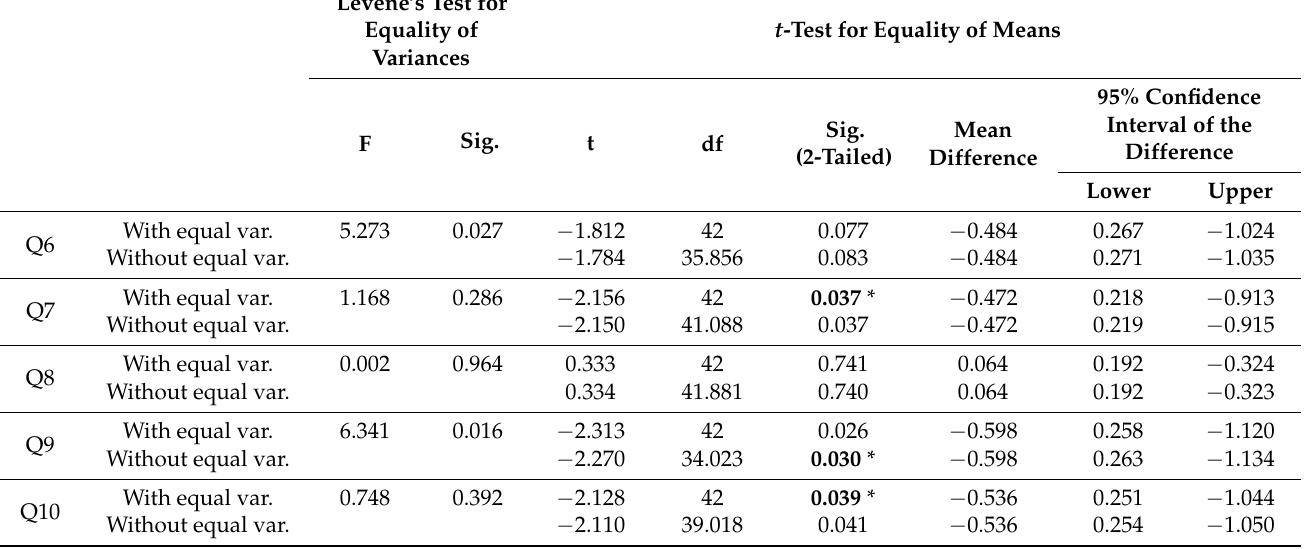
Table 7. Students’ attitudes toward enjoyment